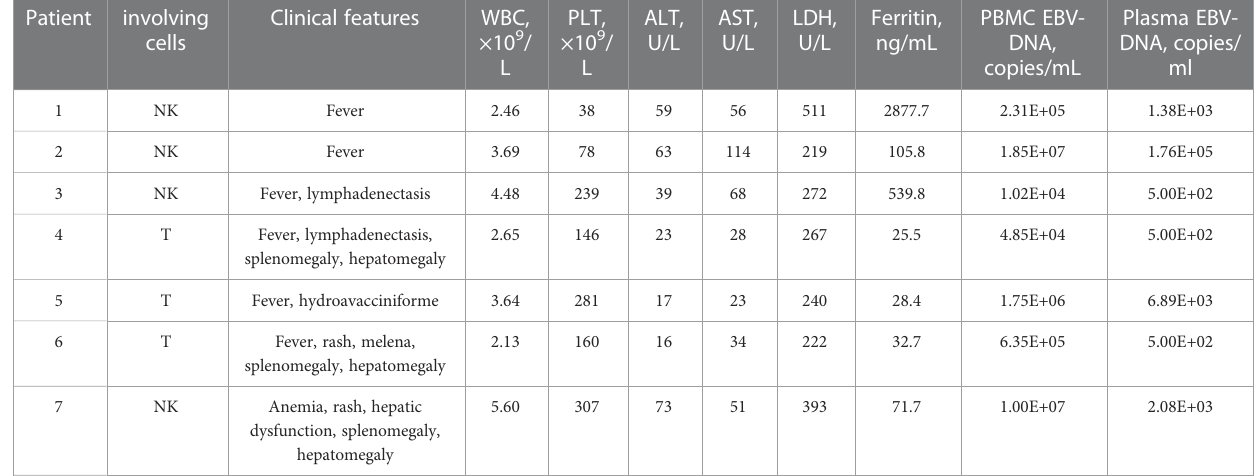
TABLE 1 Clinical and laboratory features of patients before PD-1 inhibitor infusion.